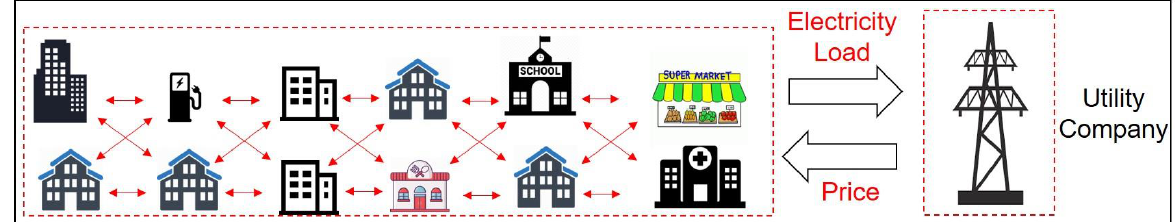
Figure 1. The interaction between a building and the other end-users as well as the utility company in a smart connected community.